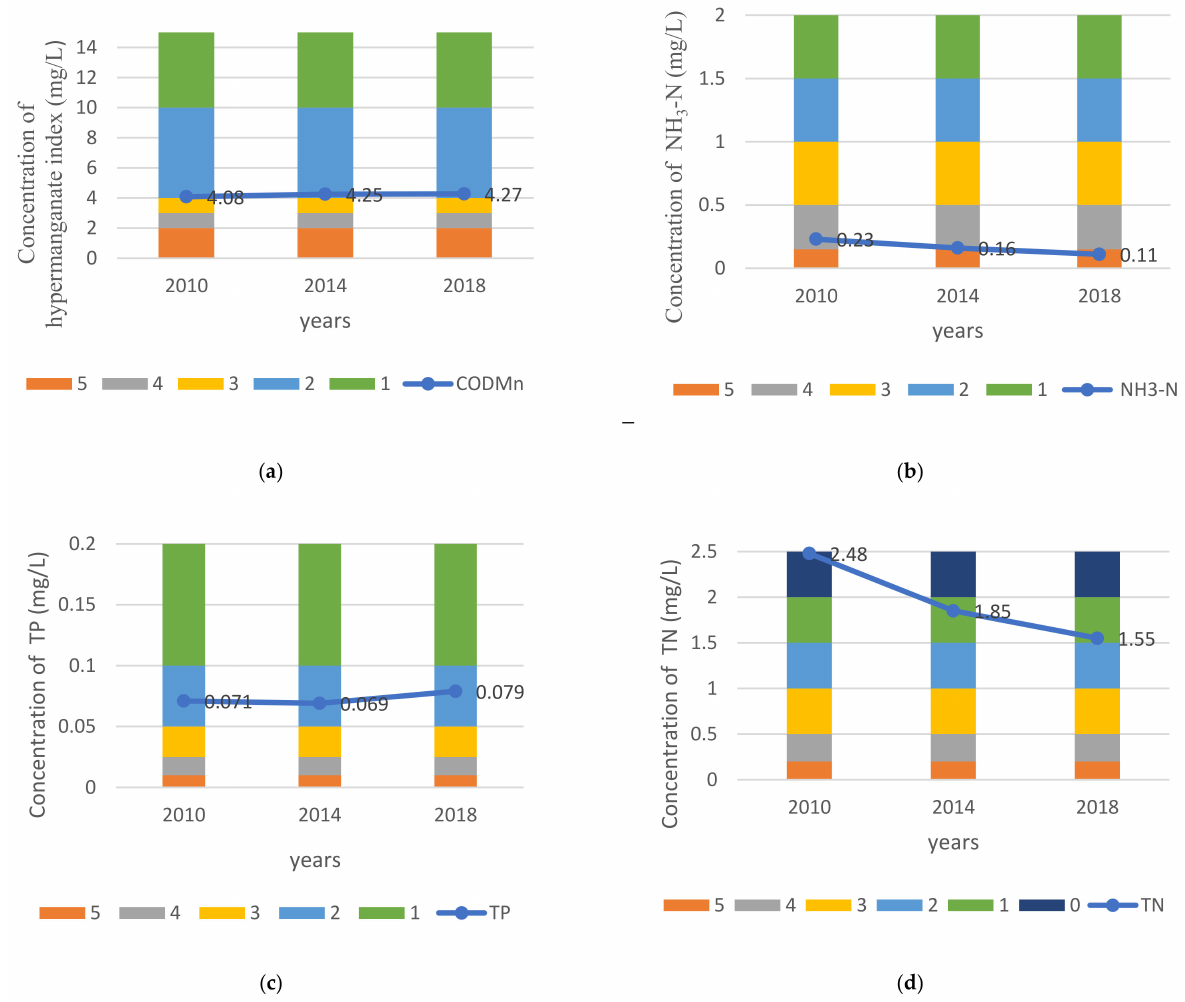
Figure 2. Assignment results of the four major pollutants. Note: The color in the figure represents the assignment level of each concentration range. If the concentration belongs to the green range, it is assigned a value of 1, and if the concentration is in the blue range, it is assigned a value of 2, and so on; orange means the assignment is 3, gray means the assignment is 4, and red means the assignment is 5. The blue points on the figure correspond to the concentration value, and the lines are used to show the change in trend of the concentration and